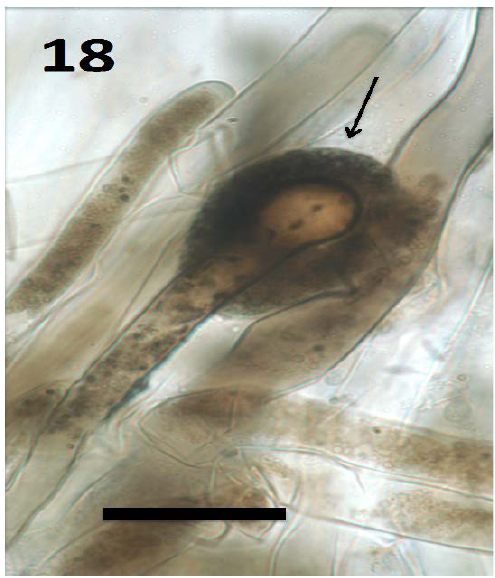
Figure 18 . Root hair of seedling of Froelichia gracilis showing cap (arrow) composed of compacted yeast cells (bar = 30 µm; stained with 3,3-diaminobenzidine followed by aniline blue).